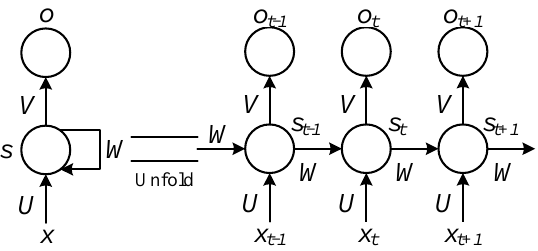
Figure 6. Local network structure of intelligent perception.